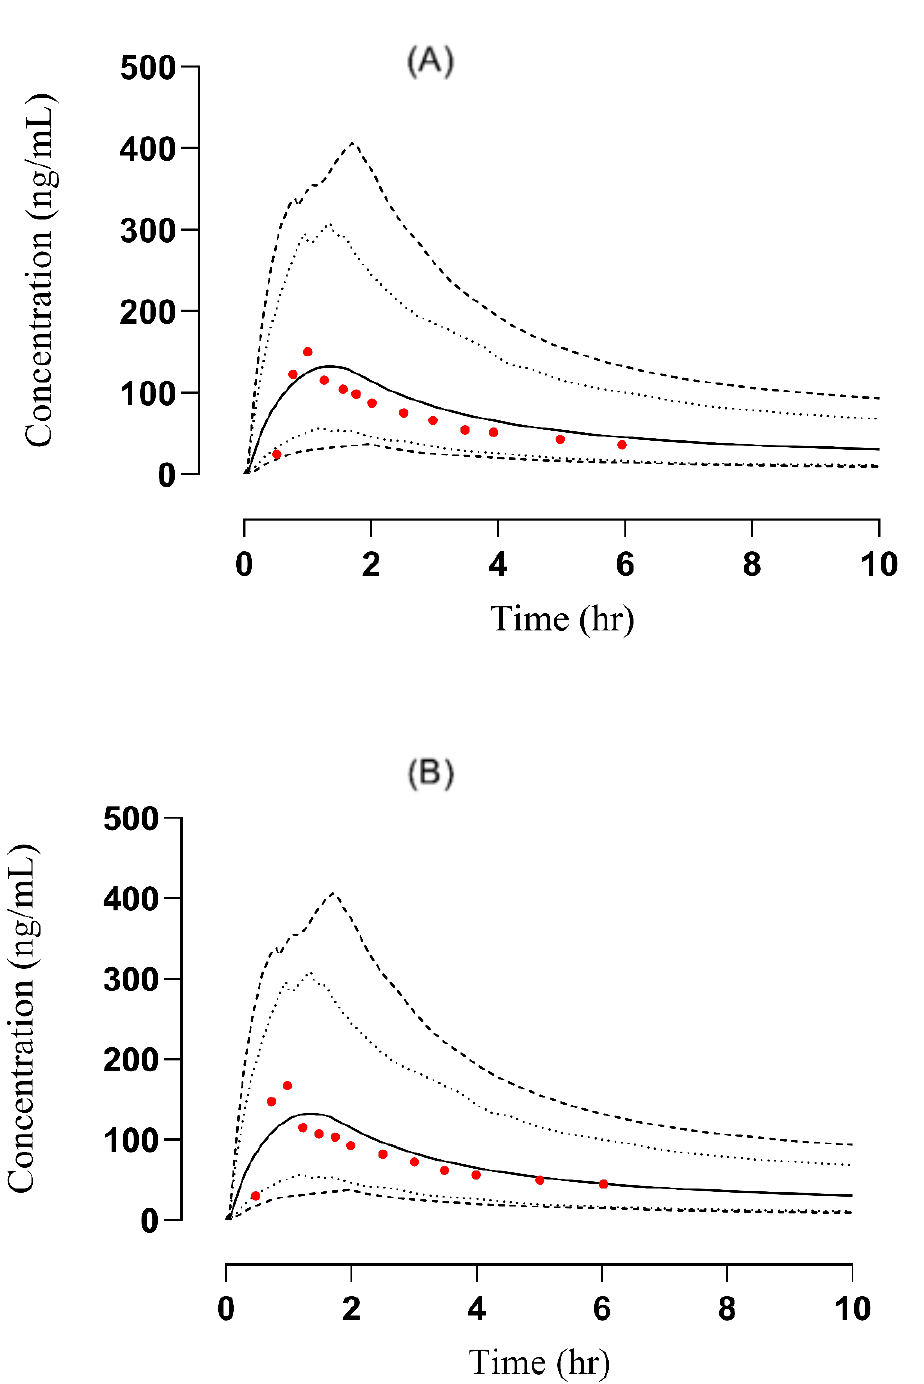
Figure 3. Comparison of observed and predicted plasma concentration versus time profile in healthy subjects after oral administration at a dose of 200 mg. ( A ) [29], ( B ) [25]. The solid line [—] indicates the arithmetic mean, dash line [- - - -] maximum and minimum, the dotted line [....] 5th–95th percentile, red dots indicate observed data, and the solid line indicated predicted data.